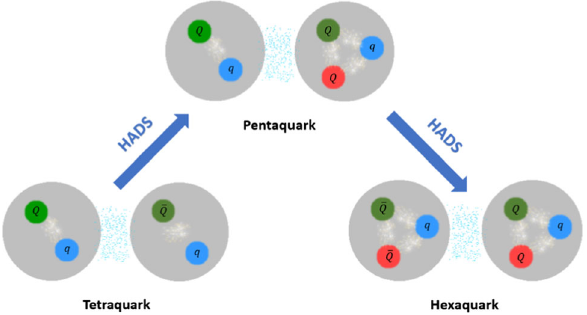
Fig. 1 HADS related hidden charm tetraquark states, triply charmed pentaquark states, and hidden charmed hexaquark